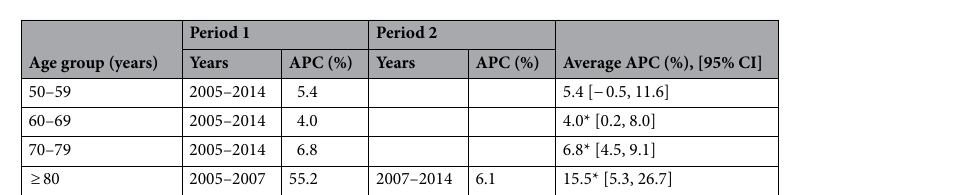
Figure 5. Trends in crude incidence rates (per 1,000,000 population) of Creutzfeldt–Jakob Disease, 2005–2014. The trends in crude incidence rates of CJD over the age of 50 years by 10-year age groups and sex are shown. The crude incidence rates per 1,000,000 population had continuous increases in the 60–69 years age groups or older.